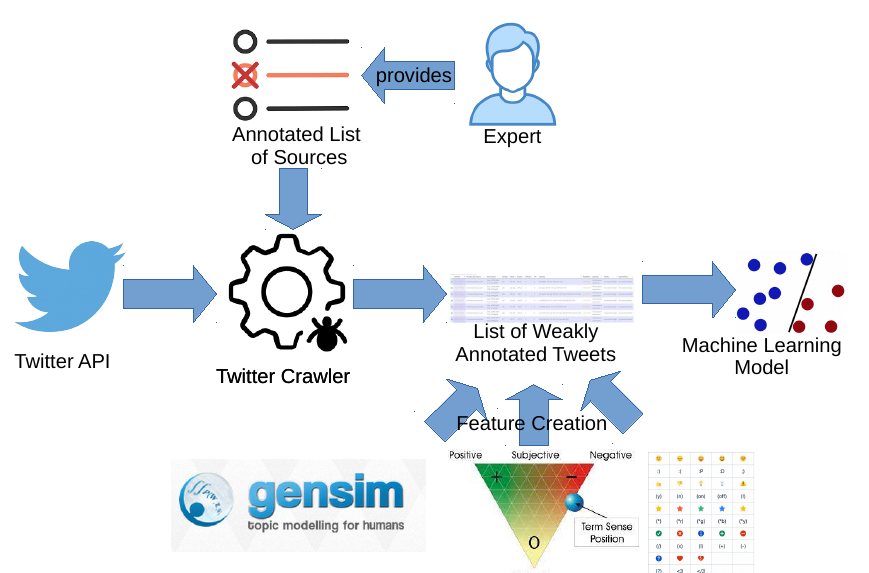
Figure 4. Schematic depiction of the overall